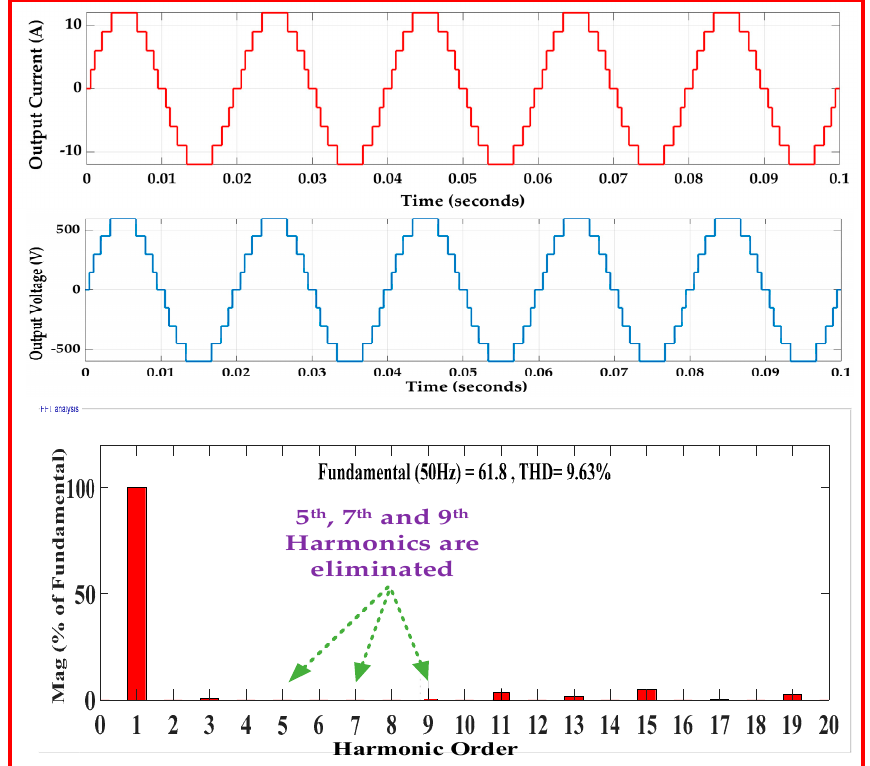
Figure 8. Harmonic profile and outputs of PEC-9.